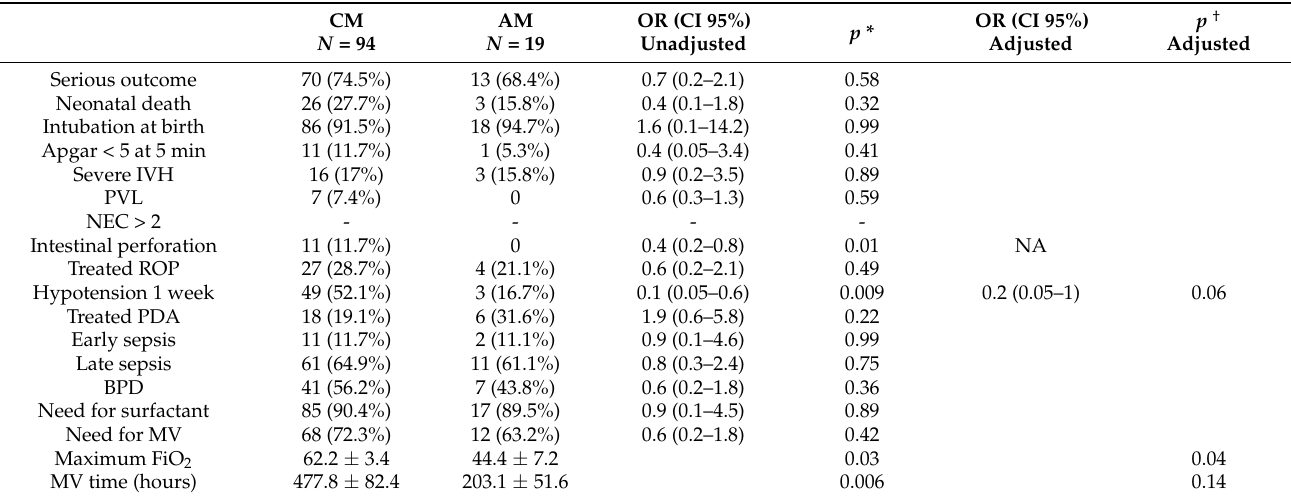
Table 3. Outcomes in <28 weeks gestational age according to interval between doses of antenatal